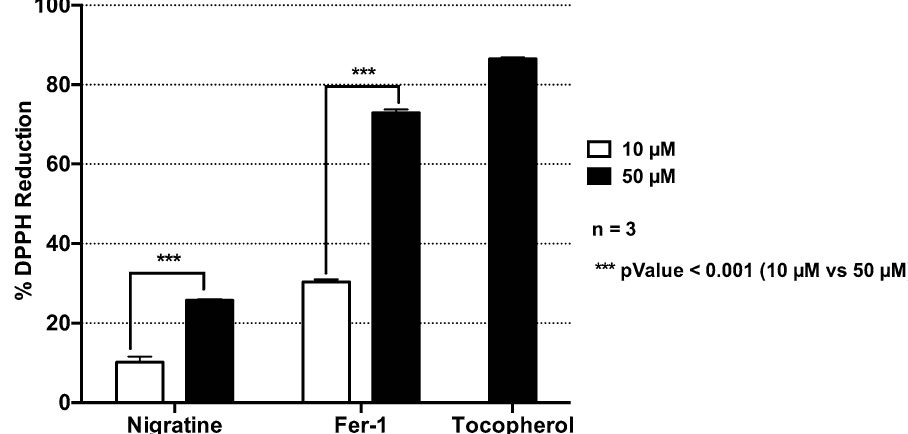
Figure 5. Antioxidant activity of nigratine. DPPH reduction assay was conducted for 30 min at room temperature after the addition of a DPPH solution at 15.85 µM (in 90/10, vol/vol, methanol/water) in 96-well plate. Reduction of DPPH was determined by absorbance measurement at 517 nm. Tocopherol (vitamin E), a well-known antioxidant, and Fer-1, as lipophylic antioxidant, were used as a positive controls. Data are shown as the mean ± SD of three